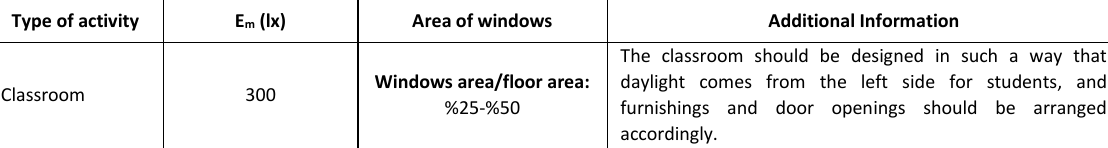
Table 3 Lighting recommendations for